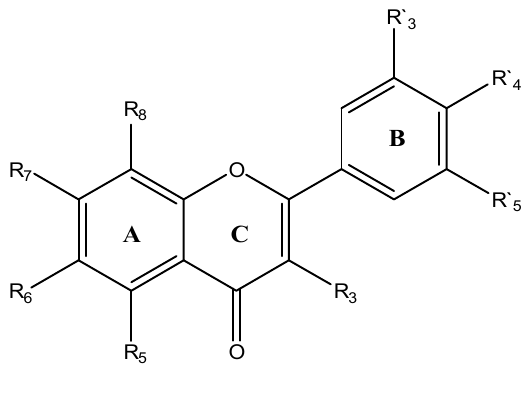
Table1 1. Chemical structure of flavonoid derivatives used in this study and their experimental and predicted activity for protein kinase